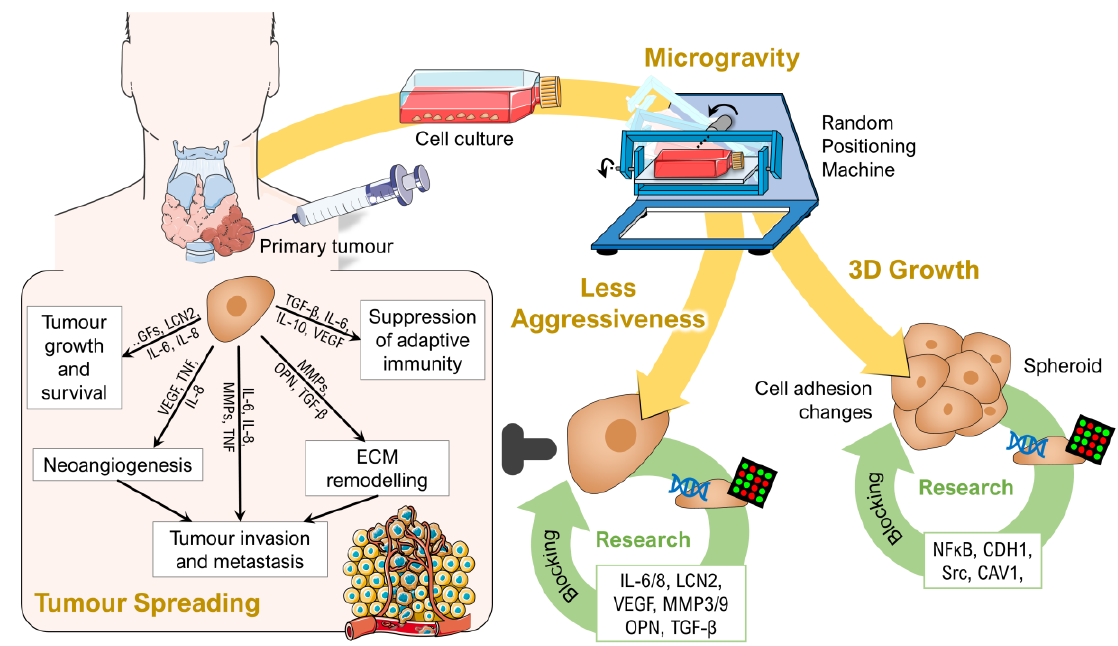
Figure 3. Overview: Current research on thyroid cancer using (simulated) microgravity. Parts of the